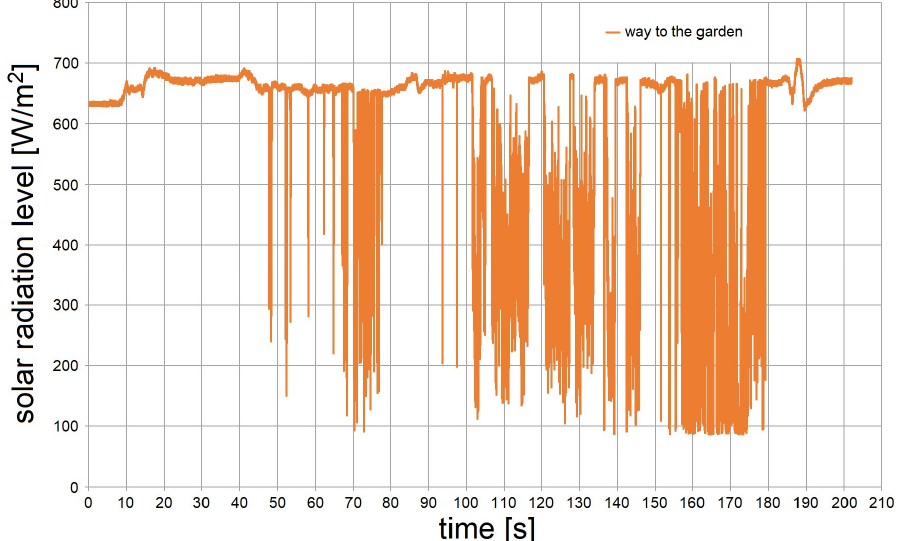
Figure 19. λ for trip from sports hall to botanical garden.